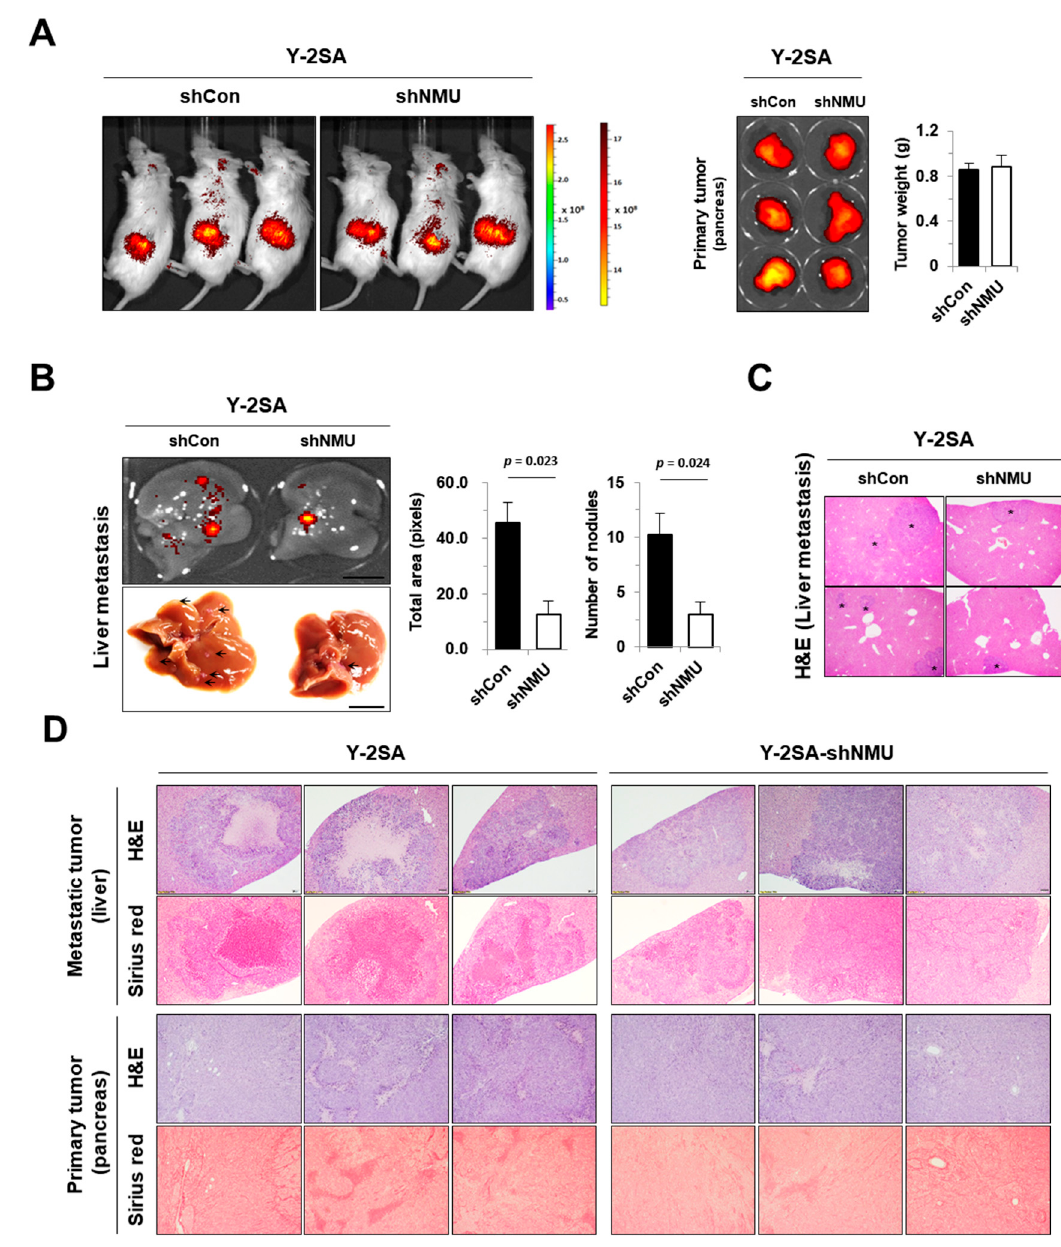
Figure 5. NMU is essential for liver metastasis induced by YAP1 in pancreatic cancer. ( A ) Representative bioluminescence images of primary pancreatic tumors. Gross and final weights were assessed at 6 weeks after orthotopic cancer cell injection ( n = 5/group). ( B ) Bioluminescence images of metastatic livers and number of tumor nodules. Scale bar: 1 cm. ( C ) Hematoxylin and eosin (H & E) staining of sections of mouse liver nodules in the Y-2SA-shCON group compared with the Y-2SA- shNMU group (magnification, ×10). ( D ) Representative H&E and Sirius red staining images of metastatic and primary tumors (magnification, ×40). Values are expressed as the mean ±